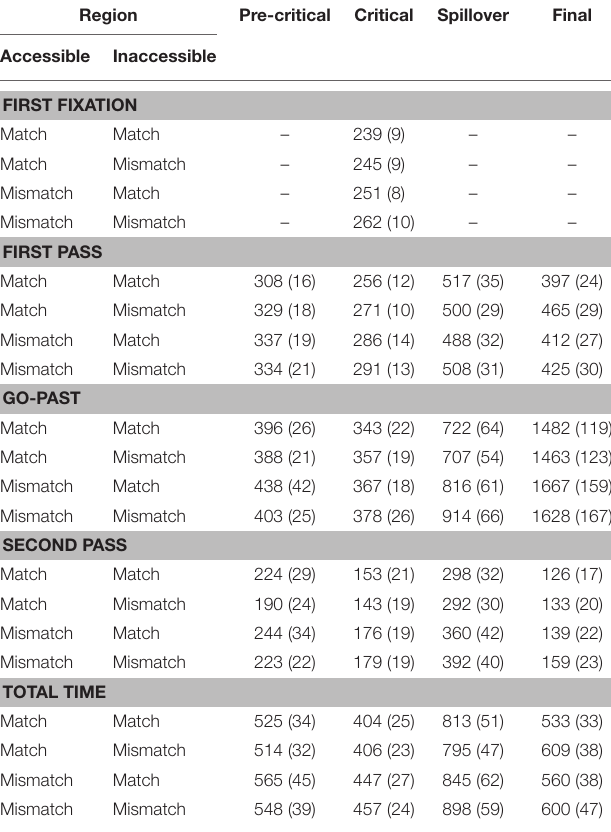
TABLE 1 | Means (and Standard Errors) for Experiment 1. Region Pre-critical Critical Spillover